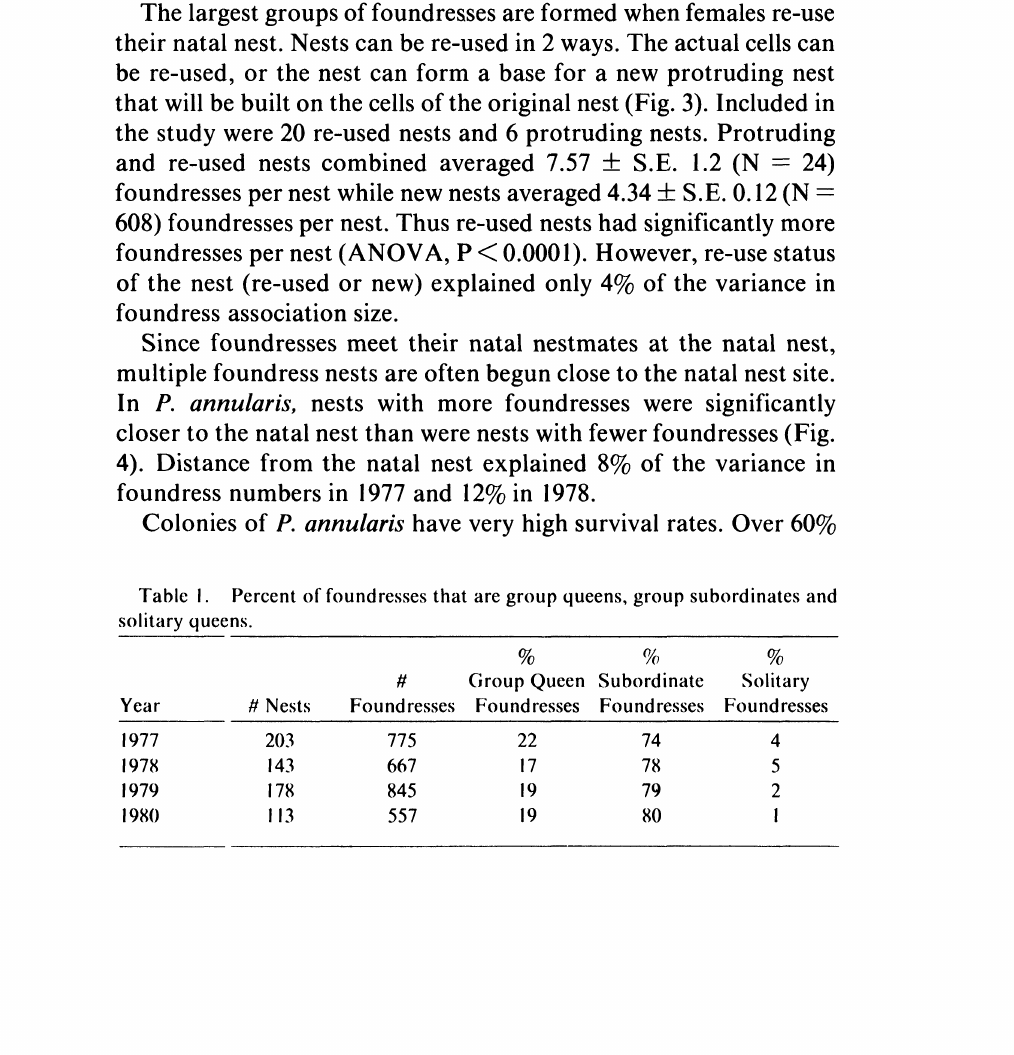
Table I. Percent of foundresses that are group queens, group subordinates and solitary